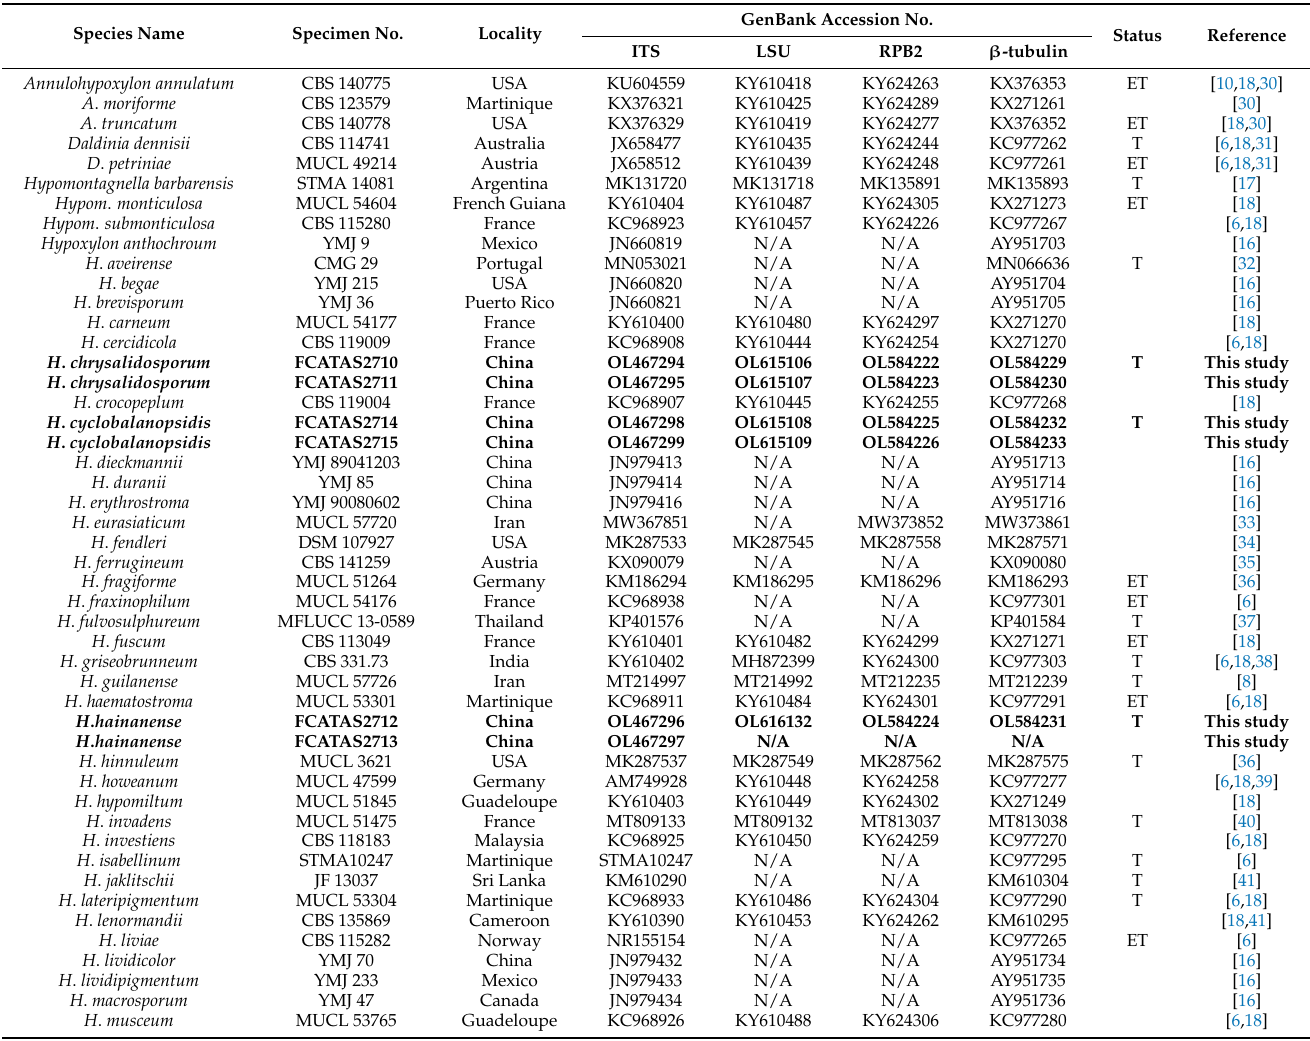
Table 1. A list of species, specimen numbers, locality, GenBank accession numbers, and references used in this study. Holotype and epitype specimens are labelled as T and ET respectively. Species highlighted in bold were derived from this study. N/A: not